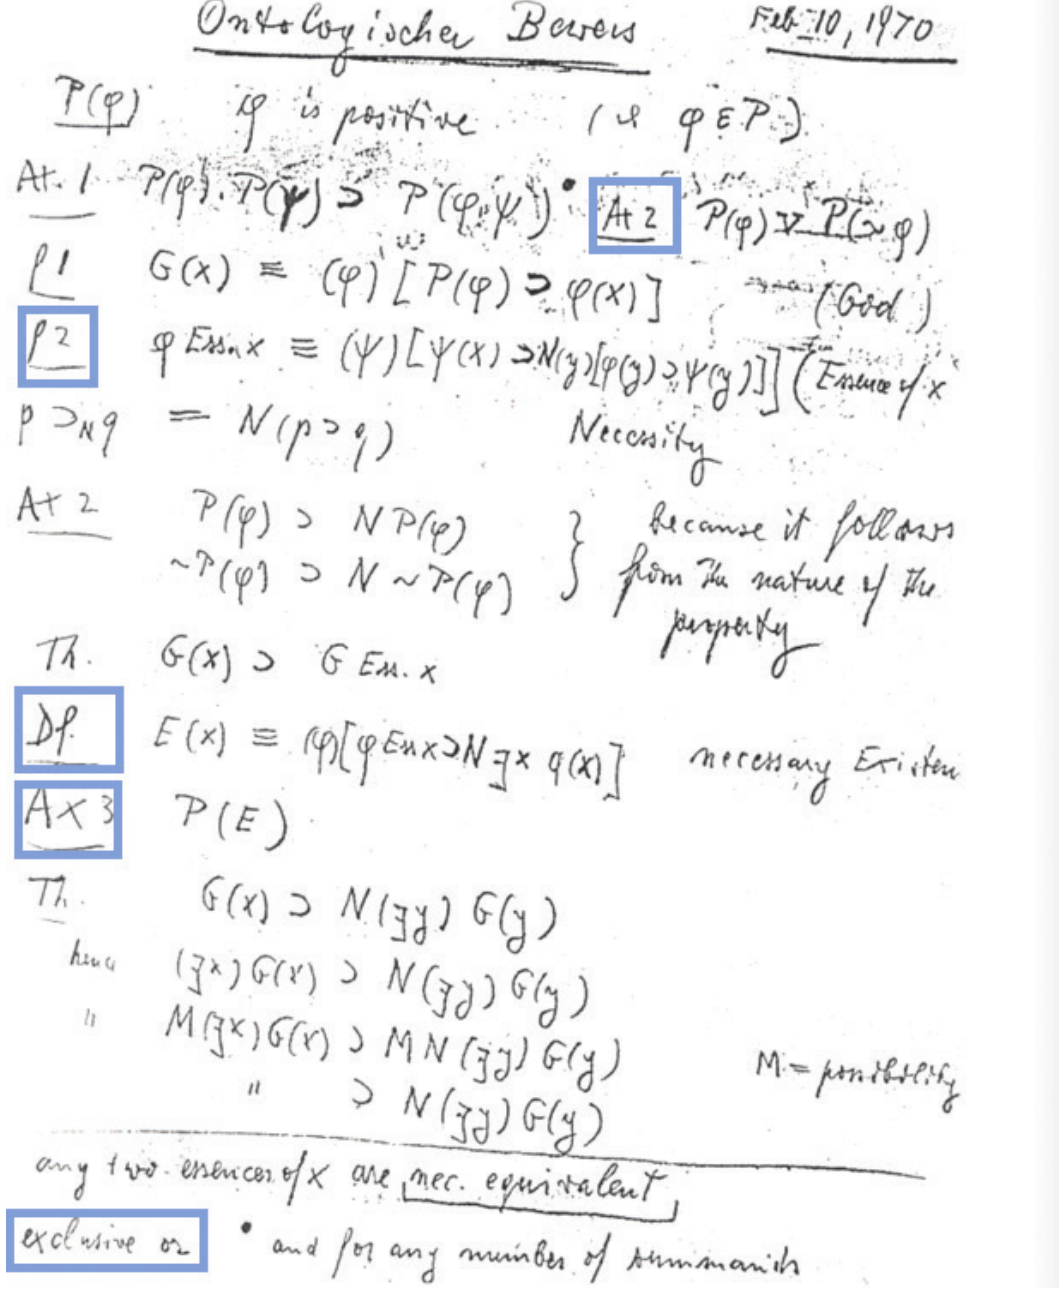
Figure 1: Page 1 of Gödel's Manuscript. The axioms causing the inconsistency in Gödel's modal logic variant of the ontologi- cal argument for the existence of God are highlighted (by us) in blue. (Unpublished works of Kurt Gödel are Copyright Institute for Advanced Study and are used with permission. All rights reserved by Institute for Advanced